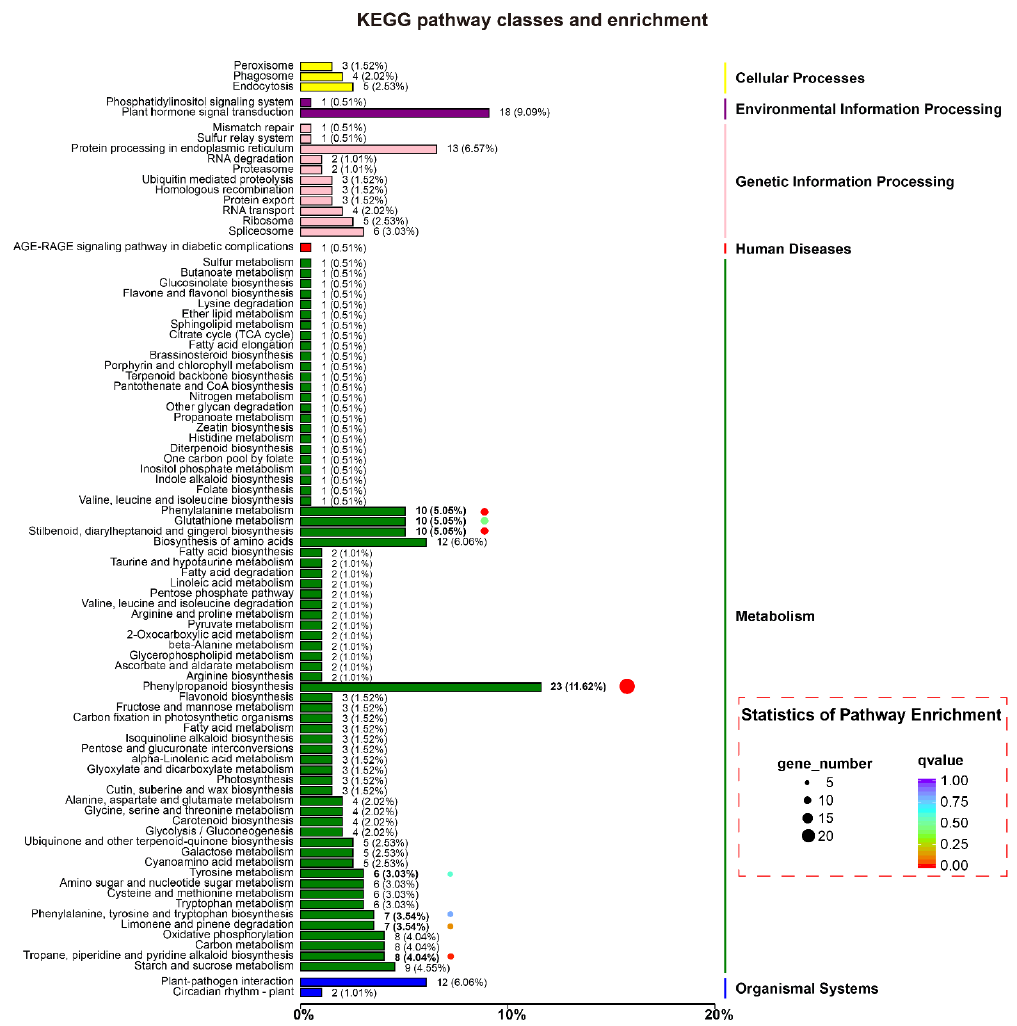
Figure 6. KEGG pathway enrichment of di ff erentially expressed genes (DEGs) in MiMIF-2 expressing Arabidopsis after treatment with flg22. DEGs were classified into 6 processes (cellular processes, environmental information processing, genetic information processing, human diseases, metabolism and organismal systems). MiMIF-2 expressing in Arabidopsis a ff ected some cellular pathways, especially phenylpropanoid biosynthesis, phenylalanine metabolism, glutathione metabolism, plant hormone signal transduction and plant–pathogen